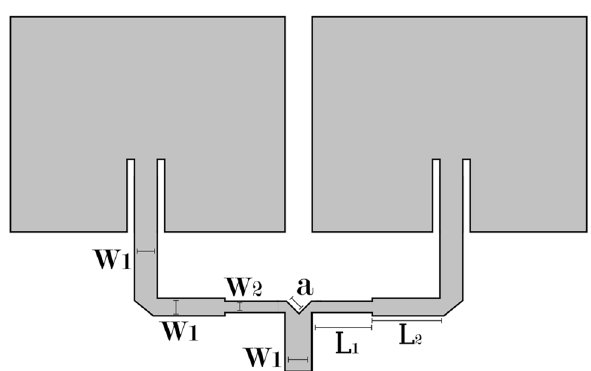
Figure 19. Antenna array and its proposed network feed.